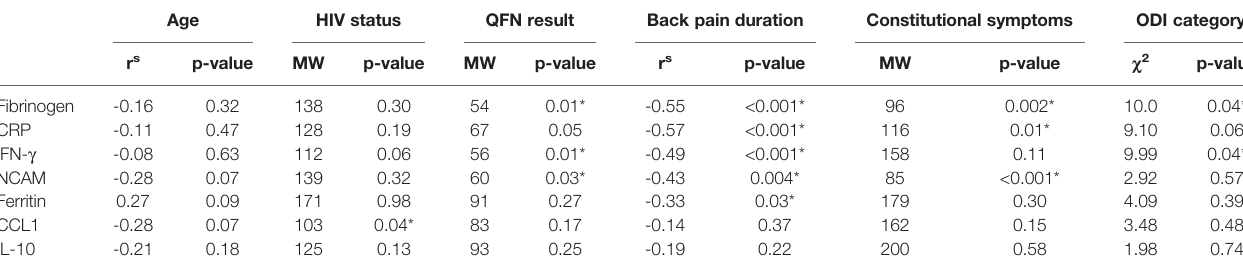
TABLE 4 | Association between selected biomarkers and demographic or clinical